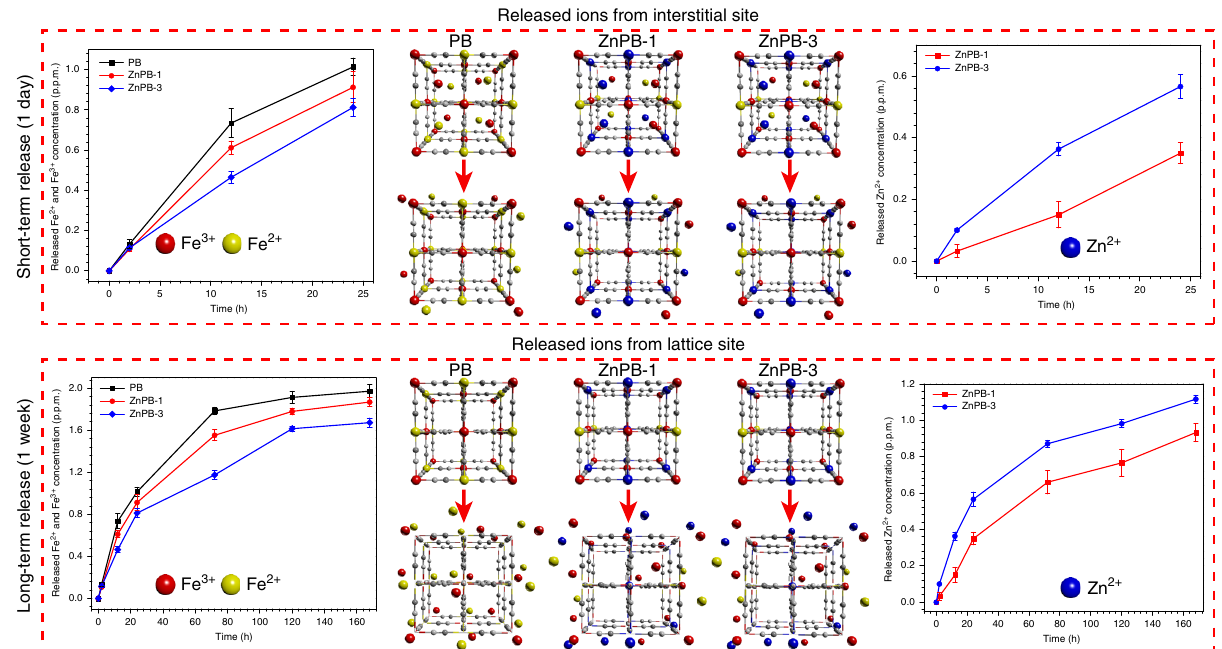
Fig. 4 Ions release behaviour. Cumulative Fe 2 + , Fe 3 + and Zn 2 + release curves of PB, ZnPB-1 and ZnPB-3 (200 p.p.m.) at 37 °C in PBS for short-term release (1 day) and long-term release (1 week). Short-term released ions (1 day) are mainly from interstitial site and long-term released ions (1 week) are mainly from lattice site. Error bars indicate means ± standard deviations ( n = 2 independent samples). Source data are provided as a Source Data fi